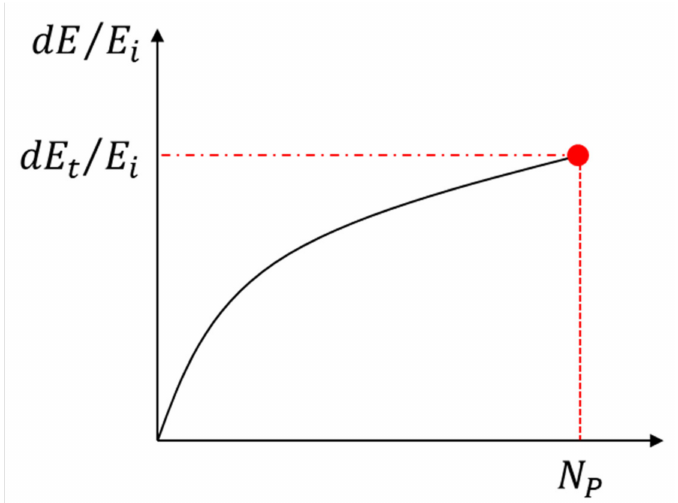
Figure 14. Model of non-linear fatigue